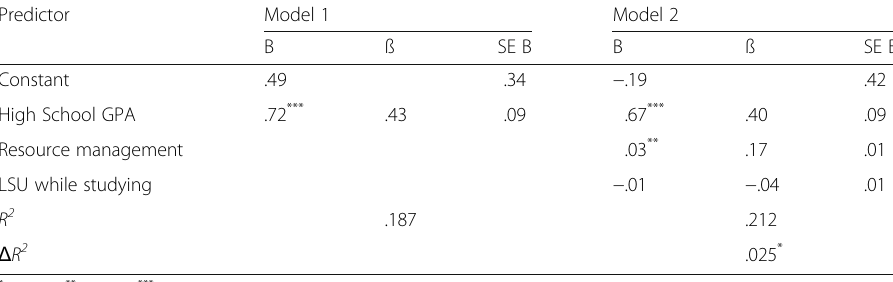
Table 3 First semester GPA, resource management and LSU regression analysis Predictor